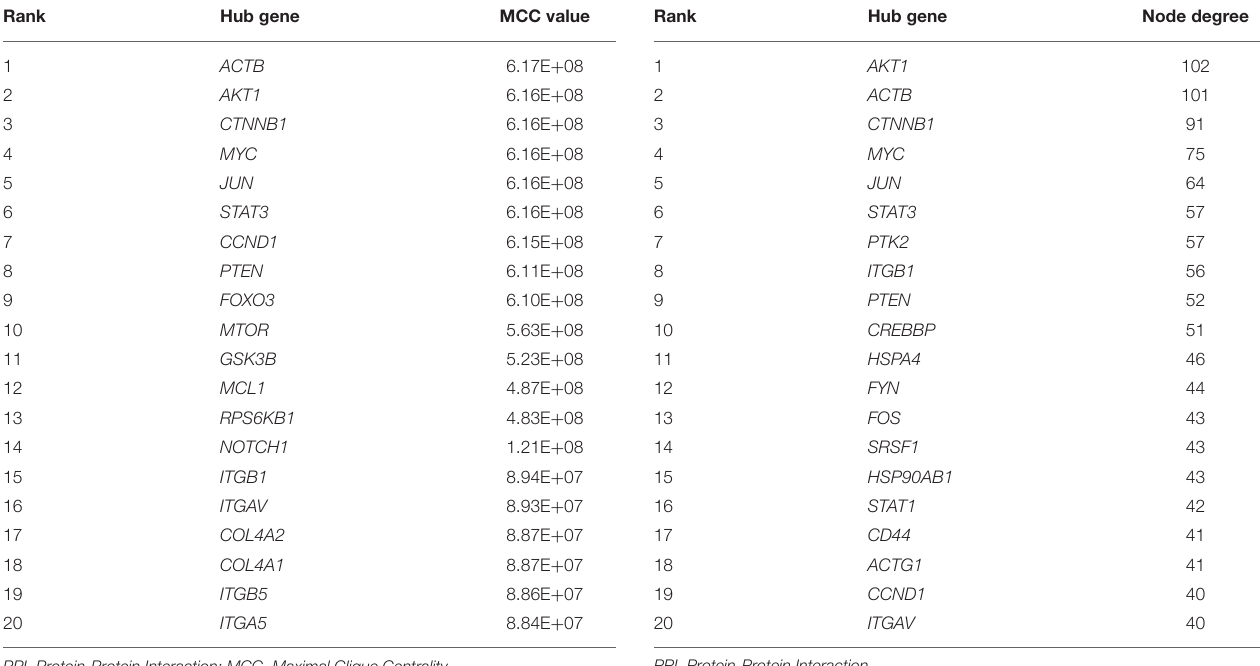
FIGURE 9 | (B) The two-level PPI network centered on YTHDF3 ; (C) The interactions among proteins with the top 20 MCC values in the whole PPI network. Red represents higher MCC values and yellow represents lower MCC values; (D) The interactions among proteins with the top 20 node degrees in the whole PPI network. Red represents higher node degrees and yellow represents lower node degrees; (E) The sub-network with the highest cluster score in the whole PPI network. Hub genes (identified by MCC method) existing in this sub-network were marked yellow; (F) The sub-network with the highest cluster score in the whole PPI network. Hub genes (identified by Degree method) existing in this sub-network were marked yellow. MCC, Maximal Clique Centrality.